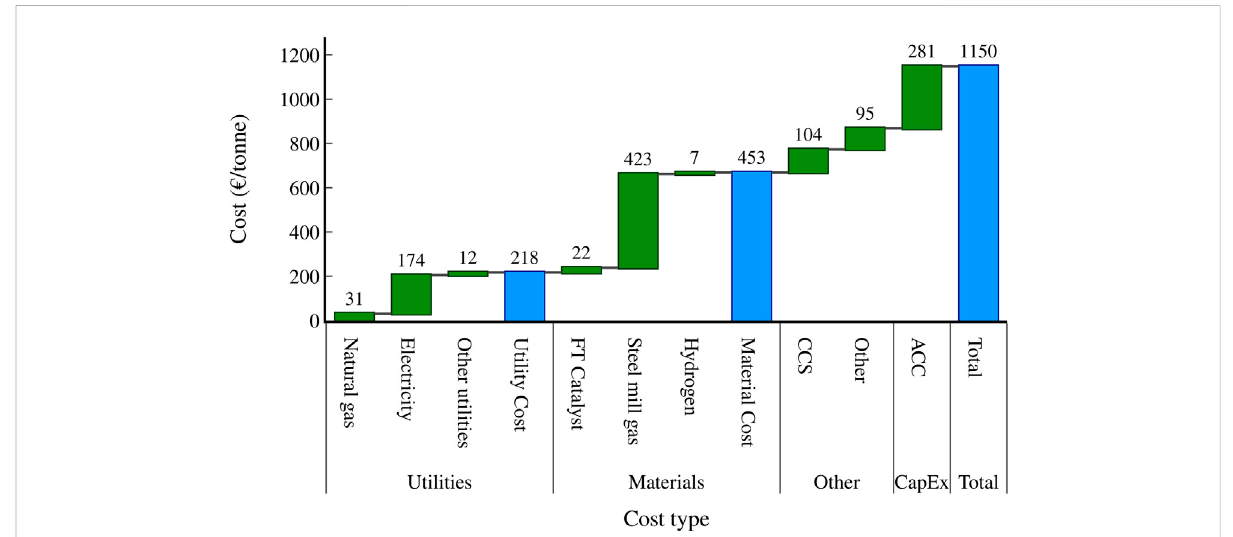
FIGURE 8 Waterfall graph highlighting the biggest contributors to the MVSP for the scenario with CCS.